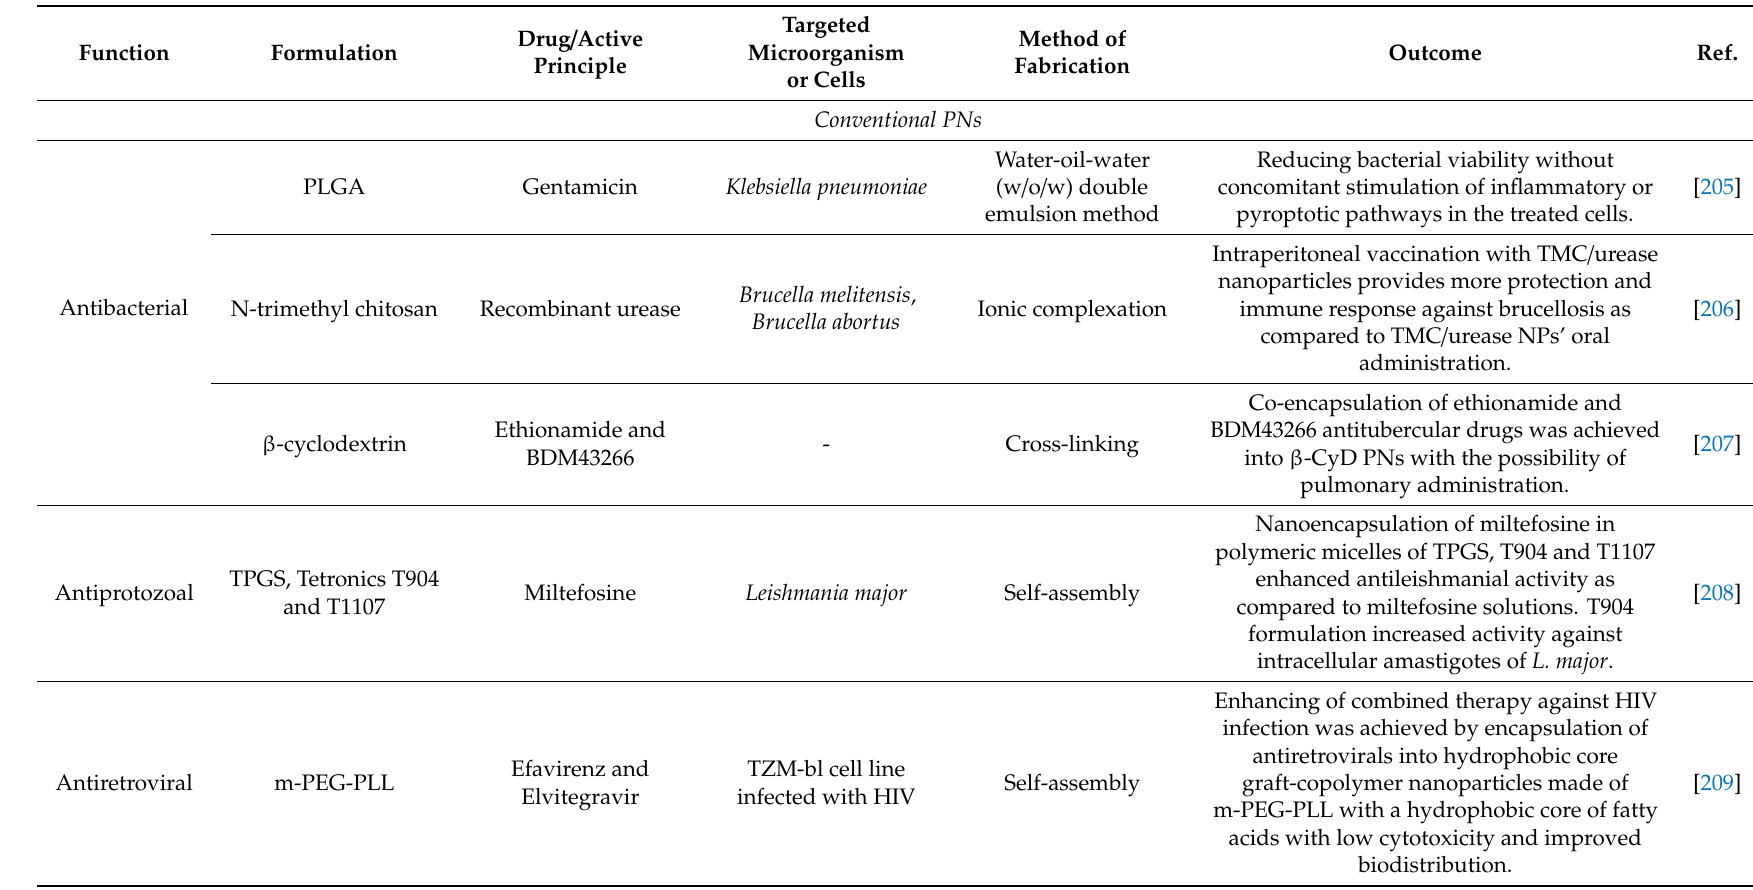
Table 3. Some recent studies that use PNs to treat intracellular